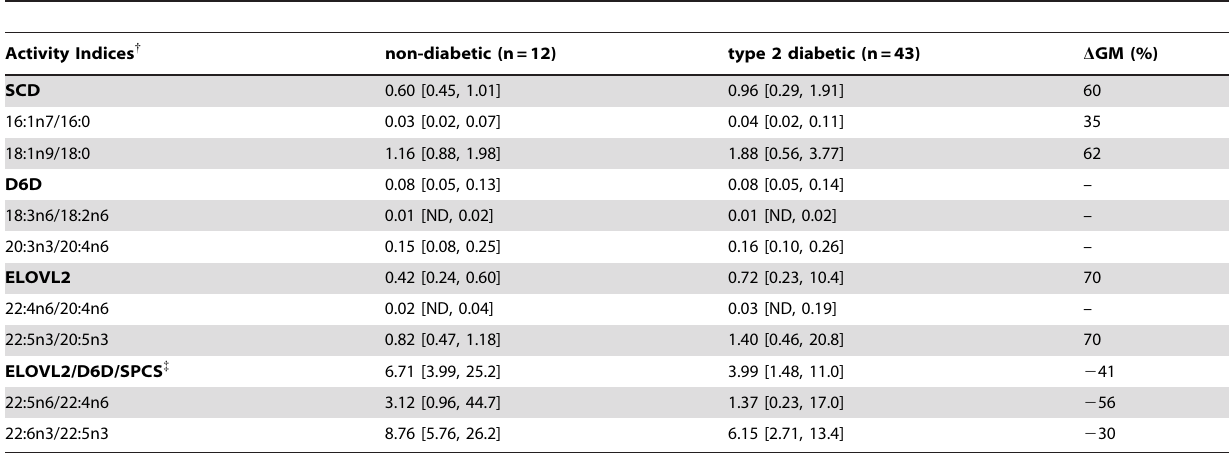
Table 3. Estimated enzyme activities in BMI-matched obese non-diabetic and type 2 diabetic African-American women based on plasma NEFA product to substrate